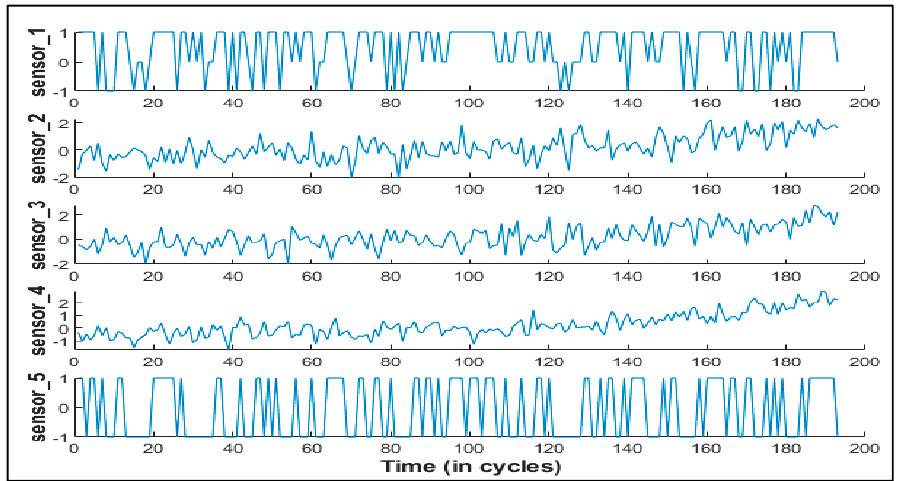
Figure 4. Result of normalization for first five sensors.